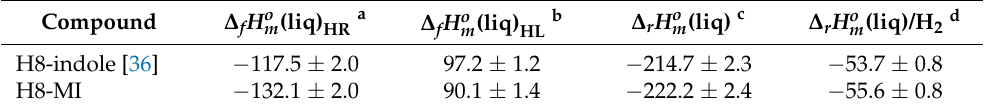
Table 9. Liquid phase reaction enthalpies, ∆ r H o m (liq), of the hydrogenation of perhydro-indoles (reaction according to Equation (8)), at T = 298.15 K ( p ◦ = 0.1 MPa, in kJ · mol − 1